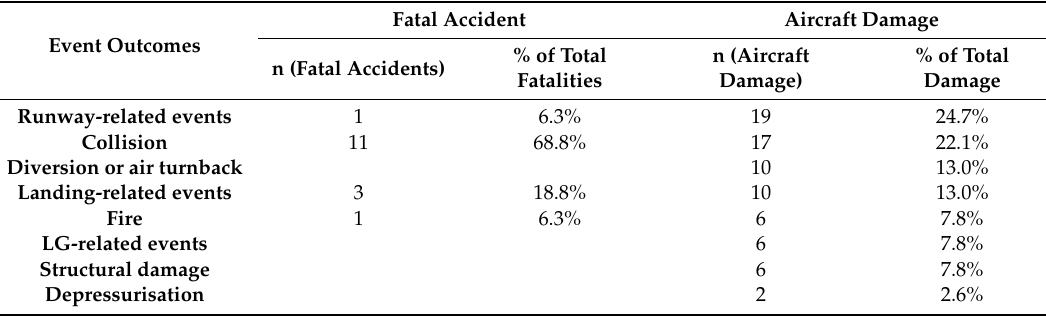
Table 7. Level 1 fatal accident and aircraft damage relationships.